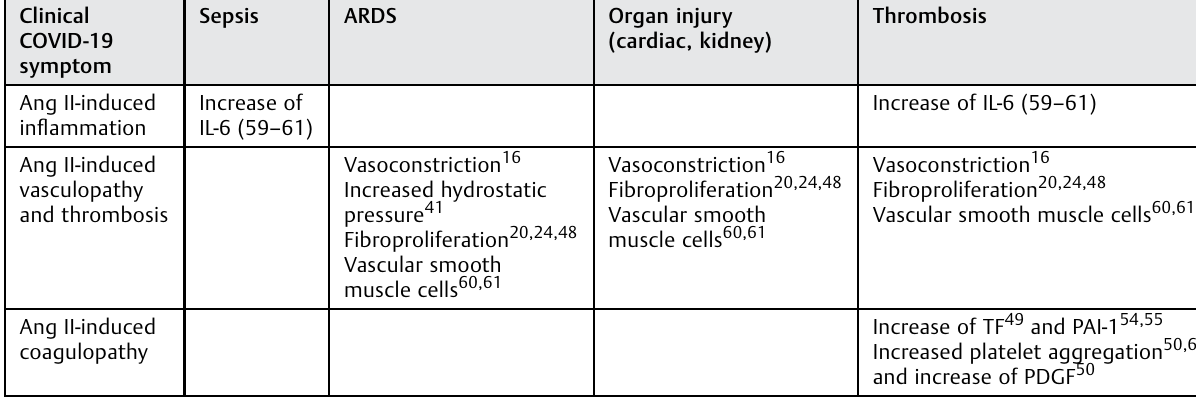
Table 2 Possible effects of angiotensin II on clinical symptoms of